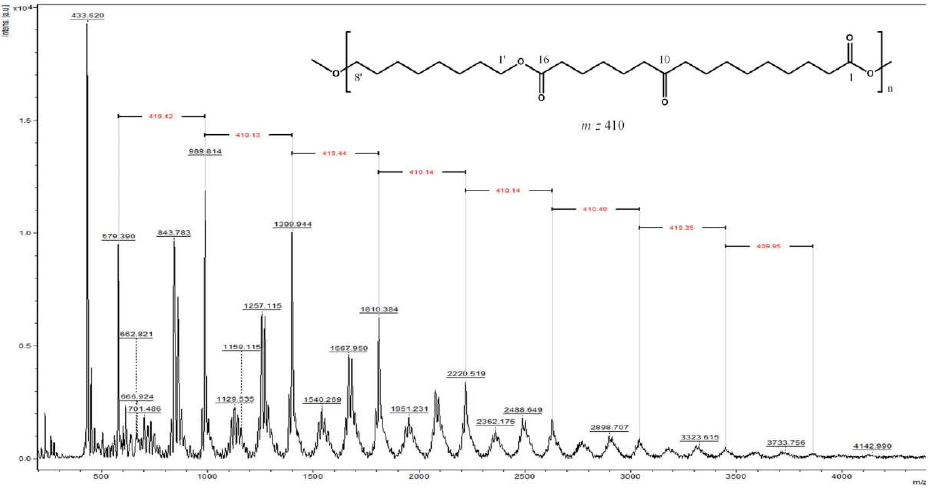
Figure 2. MALDI-TOF spectra of the polycondensation reactions.